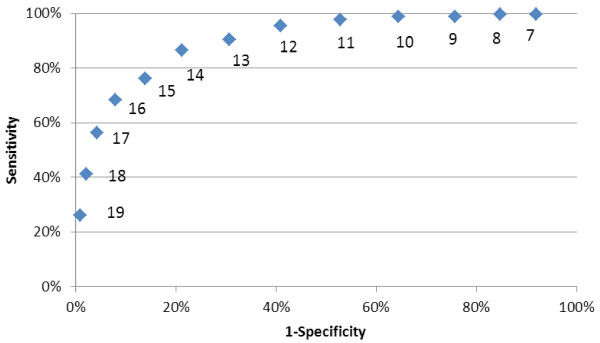
Worksheet for Computation of the Q+ Index (MDS 2.0 variables and values).